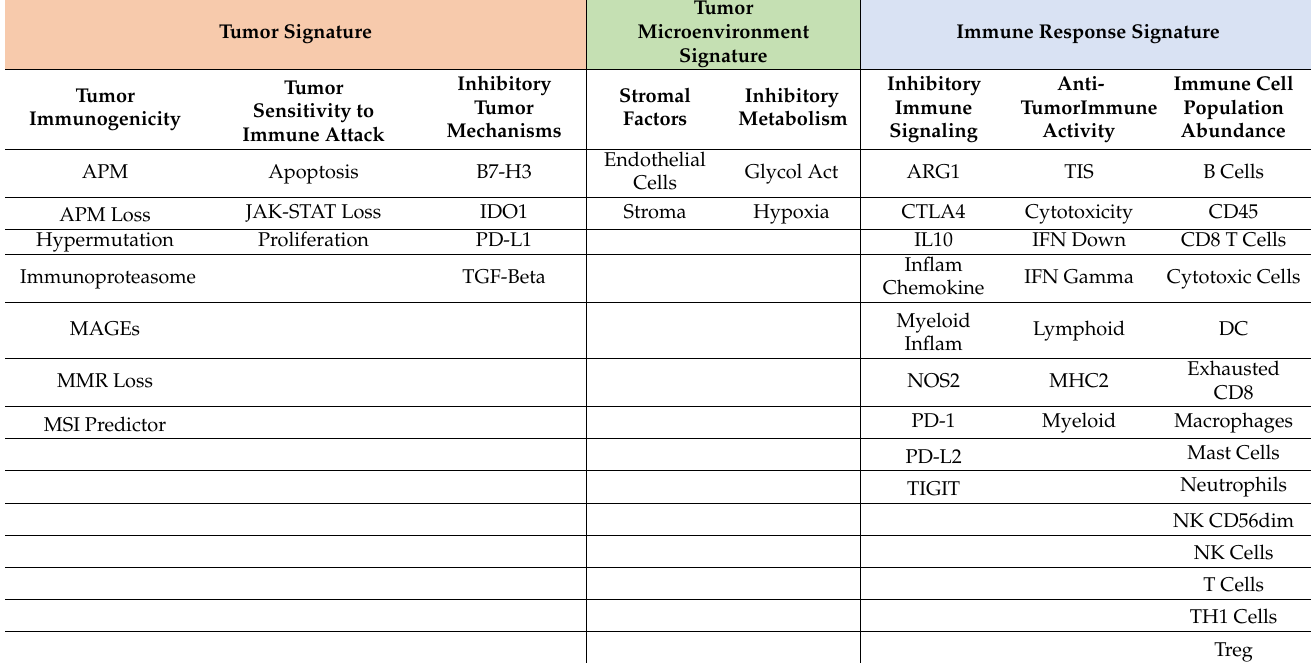
Table 2. PanCancer IO 360 Biological